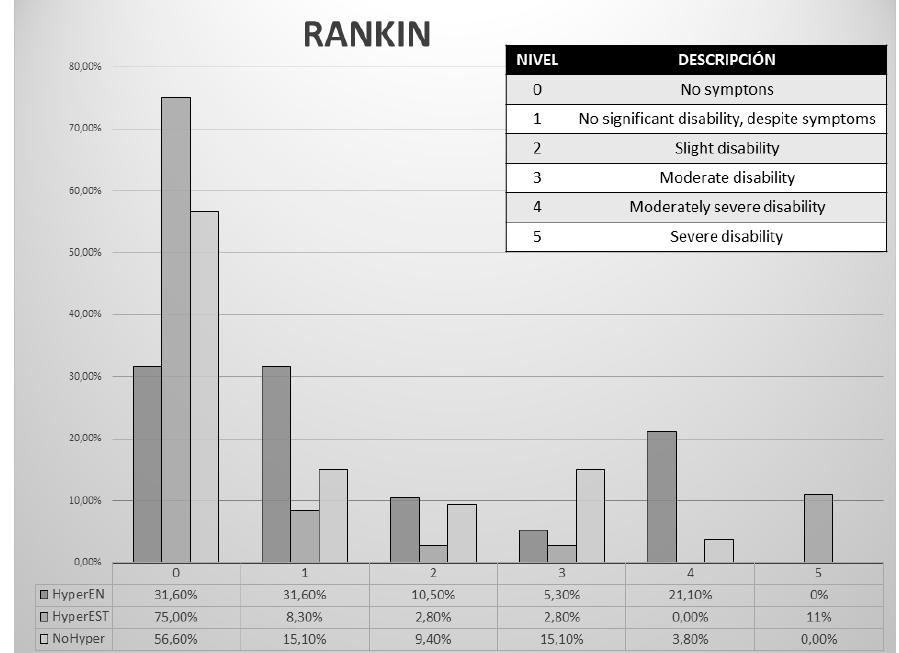
Figure 3. Comparison in functional capacity before stroke according to the Rankin scale depending on the development of hyperglycaemia associated with enteral nutrition (HyperEN), development of hyperglycaemia of stress (HyperEST), or non-development of hyperglycaemia (NoHyper). A survival analysis was performed comparing those patients who developed hyperglycaemia associated with enteral nutrition (HyperEN), those who developed hyperglycaemia of stress (HyperEST), and those who did not (NoHyper). In patients who died, a greater survival was observed in NoHyper group (25.50 (10.00–48.00) days) with respect to those of the HyperNE group (16 (7–21.25) days and the HyperEST group 8.5 (6.5–75.25) days ( p < 0.01). The associated Kaplan–Meier curves are shown in Figure 4.